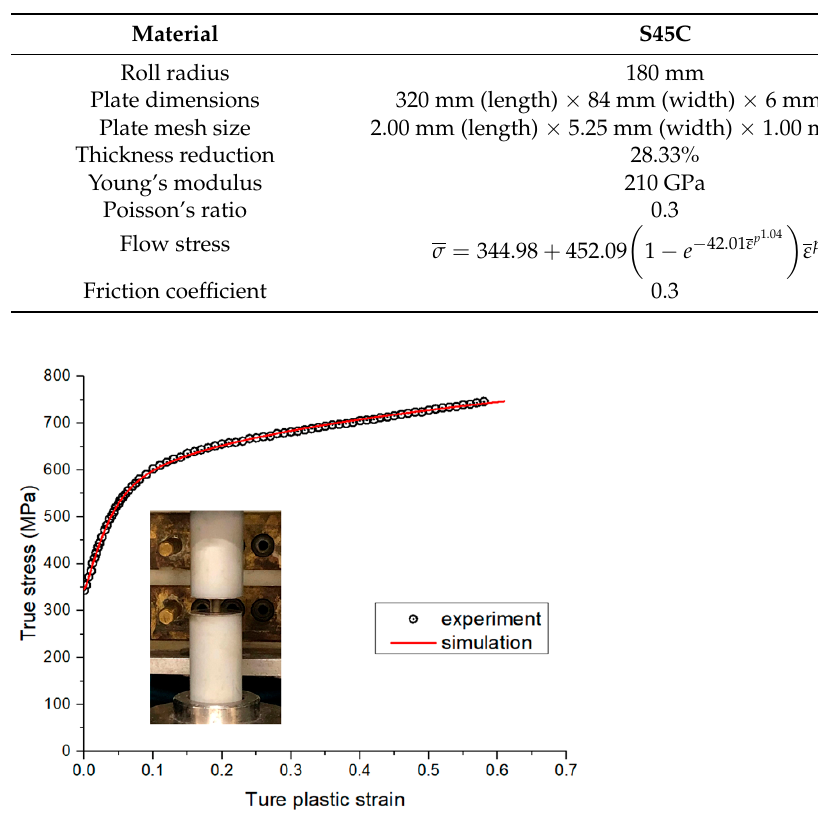
Table 1. FE analysis conditions for the S45C plate.